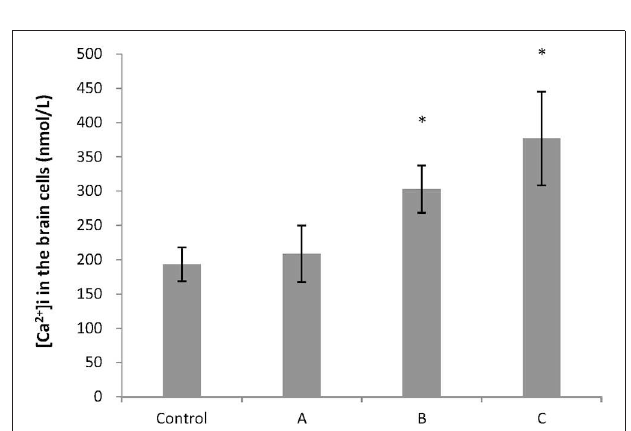
FIGURE 2 | Comparison of intracellular free Ca 2 + concentration in mouse brain cells among groups. Five mice in each group were selected for this analysis. [Ca 2 + ]i represented concentrations of intracellular free Ca 2 + .